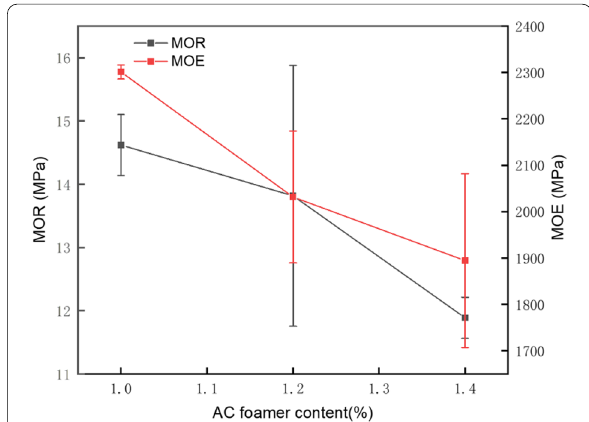
Fig. 6 MOR and MOE at different AC foaming agents with 12% PF content